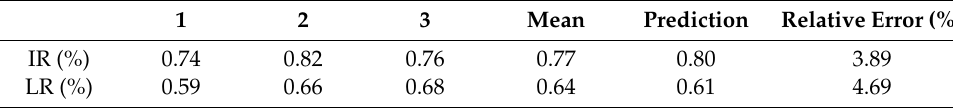
Table 11. Results of validation experiments and predicted values. 1 2 3 Mean